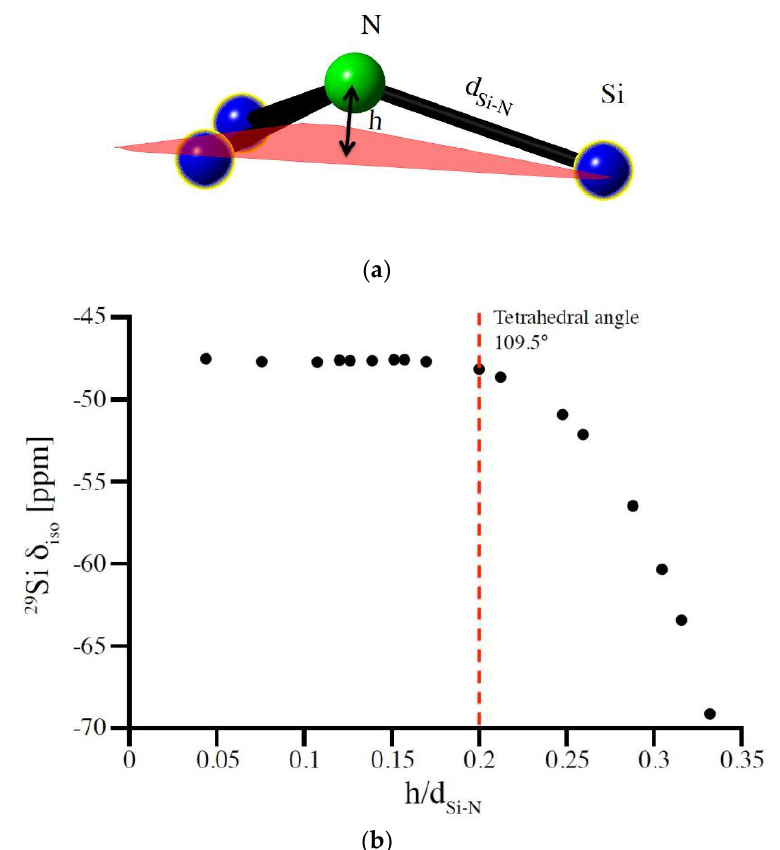
Figure 3. ( a ) Representation of the pyramidalized N atom. ( b ) changes in 29 Si NMR chemical shift with increase of the degree of pyramidalization of N atom expressed as the relation of height of nitrogen over the plane of its neighboring Si atoms (h) to the Si-N bond length (d Si-N ). The correlation was obtained for the wII-Si 3 N 4 model by changing the N position while adjusting cell parameters to maintain a Si-N bond length of 1.733 Å .